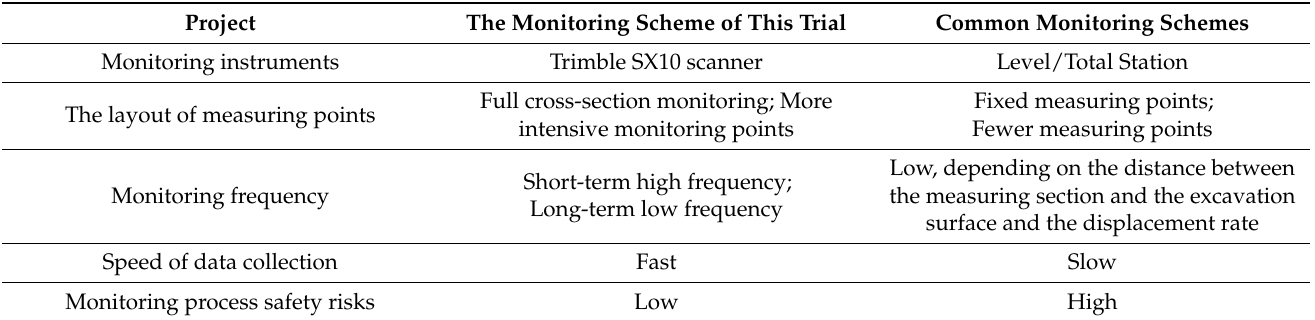
Table 2. Comparison of monitoring technologies.